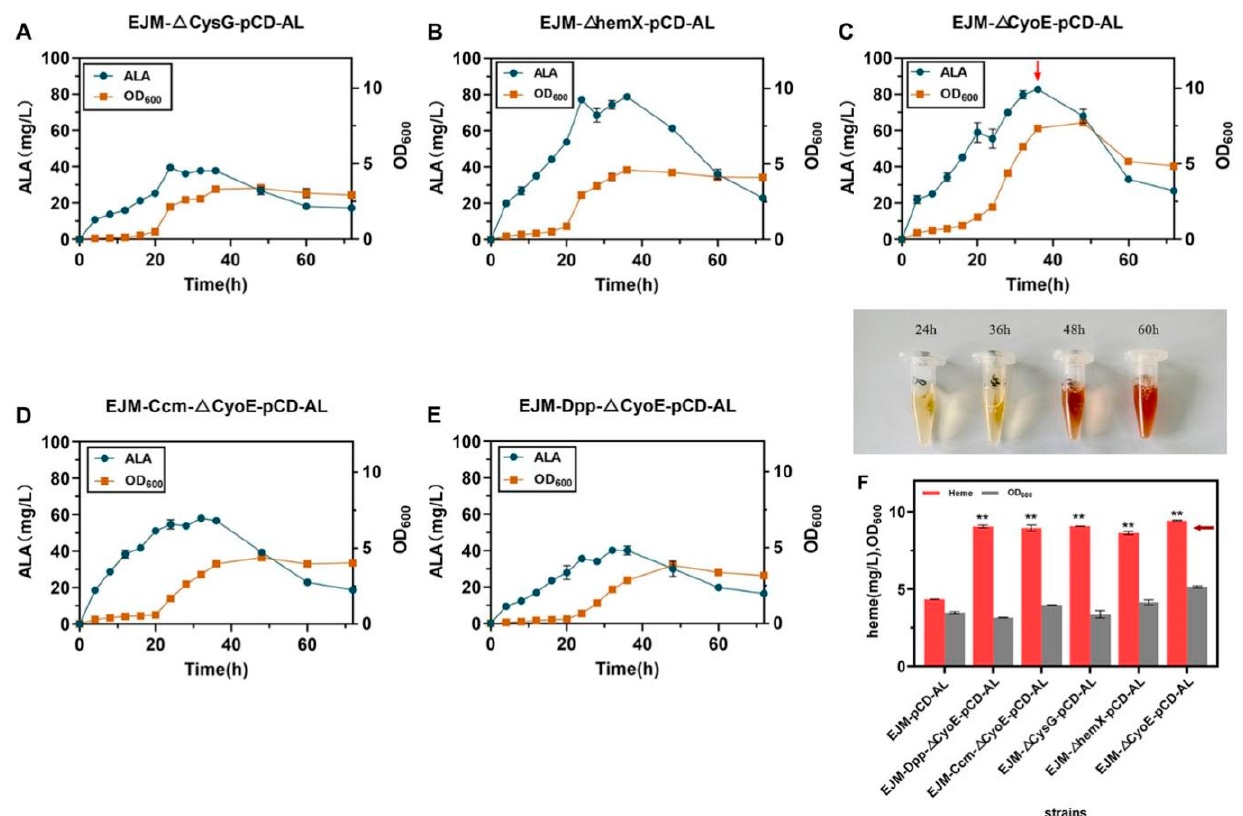
Figure 4. ( A – E ) The growth curve and ALA production of the gene-edited strain within 72 h of fermentation. ( F ) The color change in fermentation broth at different stages of fermentation and heme titer of different recombinant strains. All data indicate the mean of two independent biological experiments and error bars represent standard deviation. The symbol ** stands for and p < 0.01, as determined by Student's t-test.